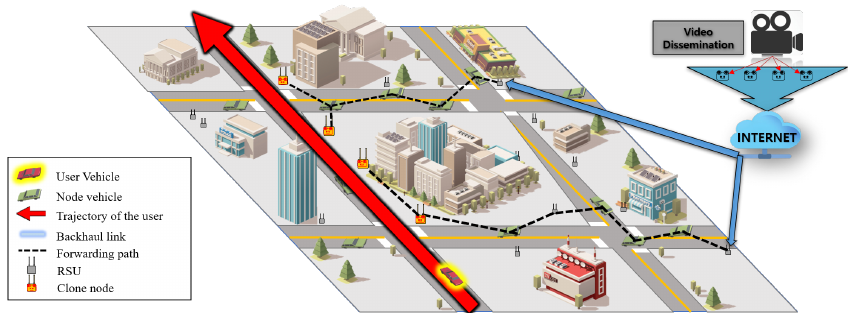
Figure 1. Clone streaming service